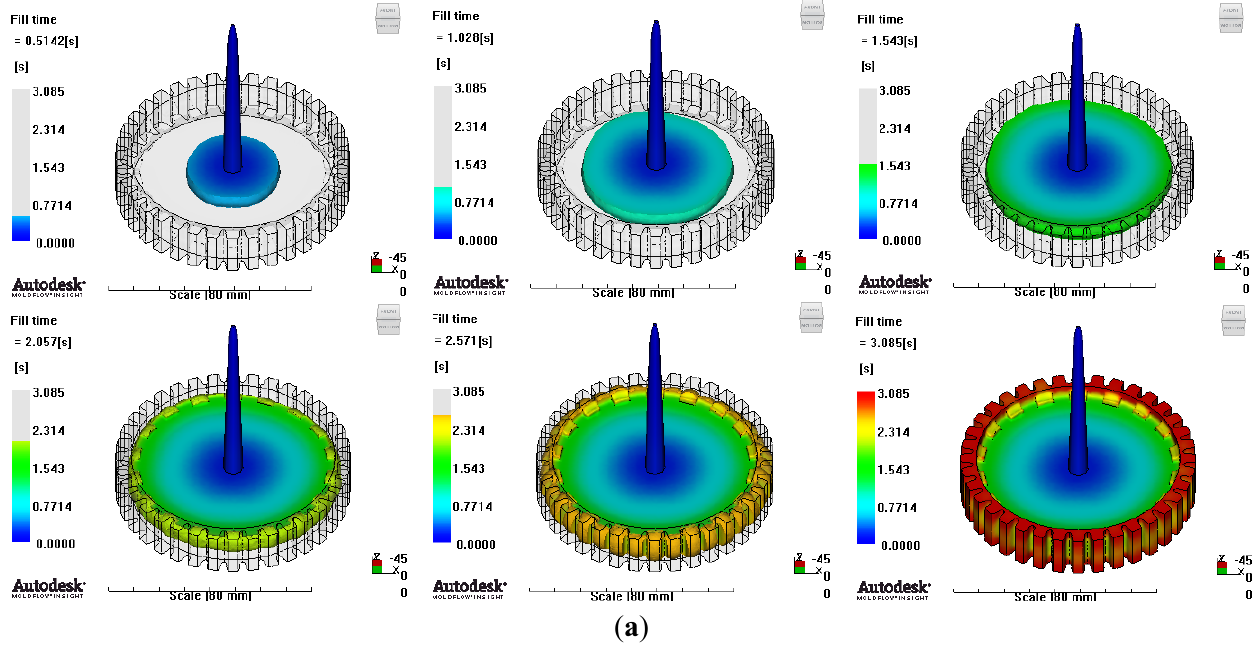
Figure 5. Resin-filling pattern analysis of plastic worm wheel. ( a ) Injection-filling pattern of spur tooth form worm wheel; ( b ) Injection-filling pattern of helical tooth form worm wheel; ( c ) Injection-filling pattern of worm wheel frame